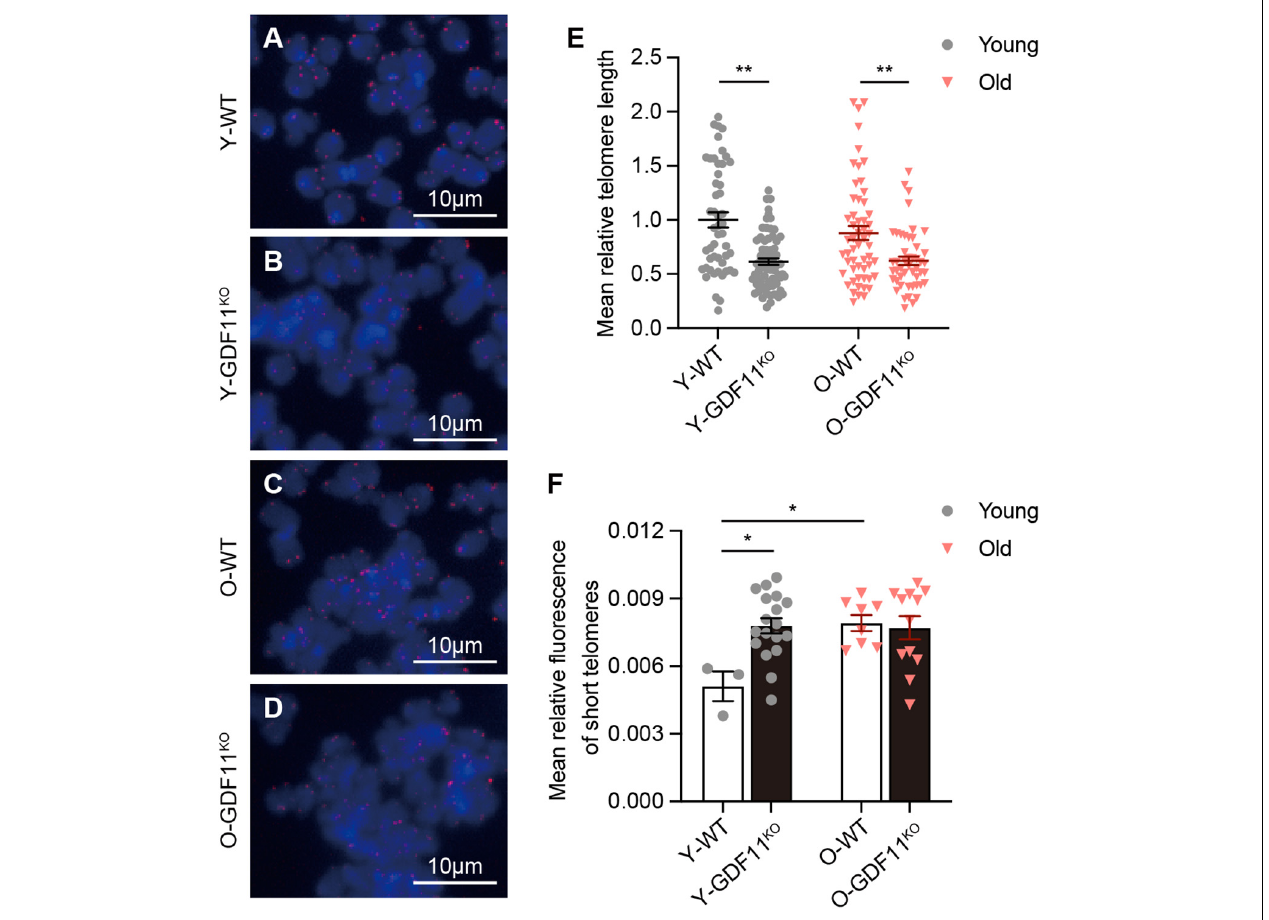
FIGURE 1 | In vitro loss of growth differentiation factor 11 (GDF11) shortens telomere length in Neuro 2a cells. Representative images of telomere quantitative fluorescence in situ hybridization (Telo-FISH, A–D ) in single clone-derived GDF11 KO or wild type (WT) Neuro 2a cells; young (Y, 10 days in culture), old (O, 65 days in culture). Quantification of the average telomere length (E) (two-way ANOVA, interaction: F ( 1 , 217 ) = 1.513, p = 0.2201; WT vs. GDF11 KO : F ( 1 , 217 ) = 37.64, p < 0.0001; young vs. old: F ( 1 , 217 ) = 1.183, p = 0.2779; Sidak’s test, young: WT vs. GDF11 KO , p < 0.0001; old: WT vs. GDF11 KO , p < 0.0018; Y-WT: n = 50, Y-GDF11 KO : n = 68, O-WT: n = 66, O-GDF11 KO : n = 48), and the average relative fluorescence of short telomeres (F) (two-way ANOVA, interaction: F ( 1 , 37 ) = 6.364, p = 0.0161; WT vs. GDF11 KO : F ( 1 , 37 ) = 4.643, p = 0.0378; young vs. old: F ( 1 , 37 ) = 5.642, p = 0.0228; Y-WT: n = 3, Y-GDF11 KO : n = 18, O-WT: n = 8, O-GDF11 KO : n = 12). Data are represented as mean ± SEM, * p < 0.05, ** p < 0.01. Scale bars, 10 µ